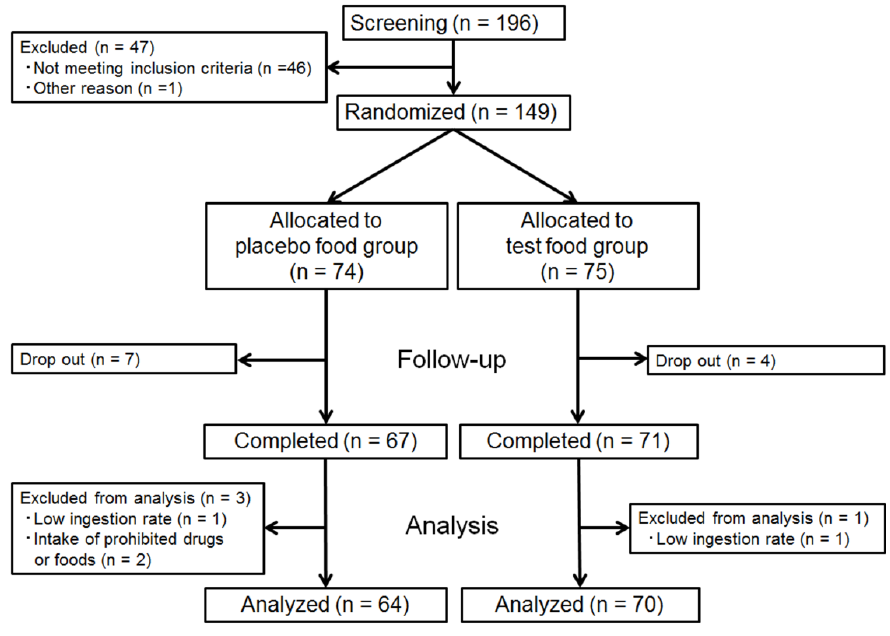
Figure 2. The study flow diagram.